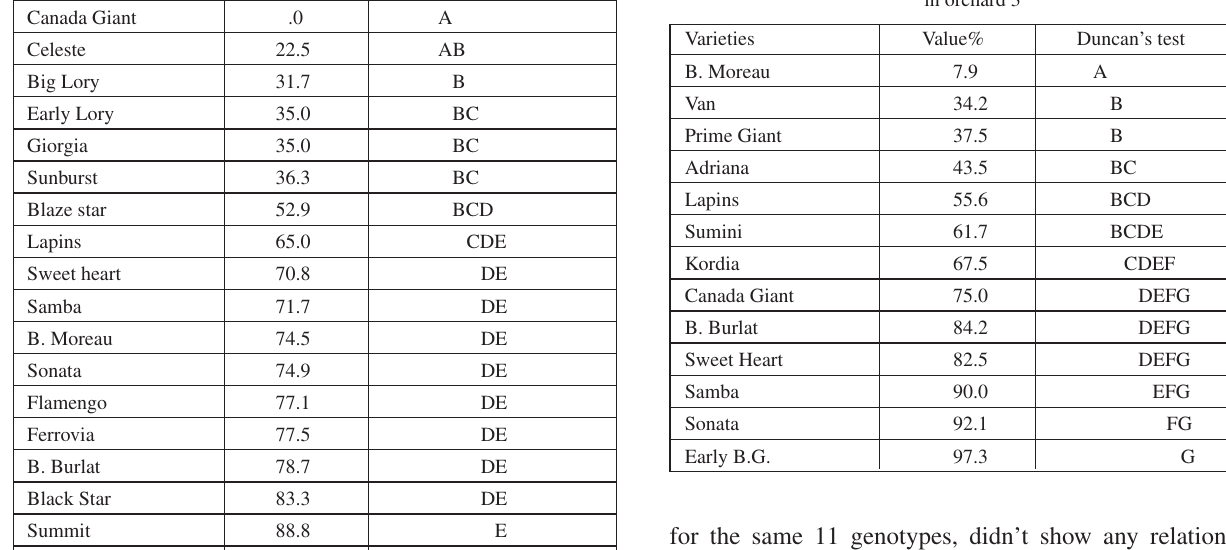
Table 1. Average of flowers percentage destroyed by spring frost, in orchard 1 Varieties Value% Duncan’s test Canada Giant .0